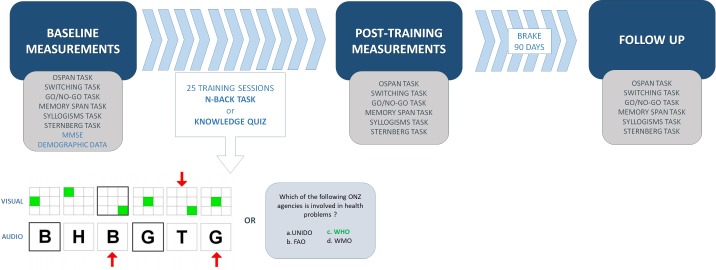
Study design with examples of a training tasks.